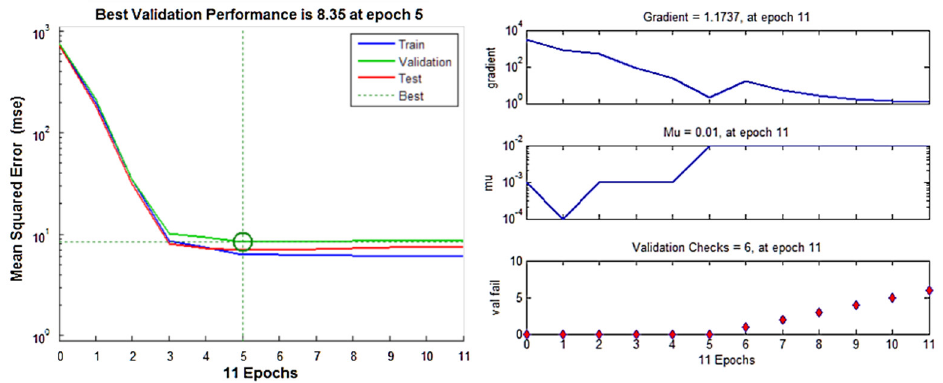
Figure 19. Training state and performance of the generated NN1 model for CCU.